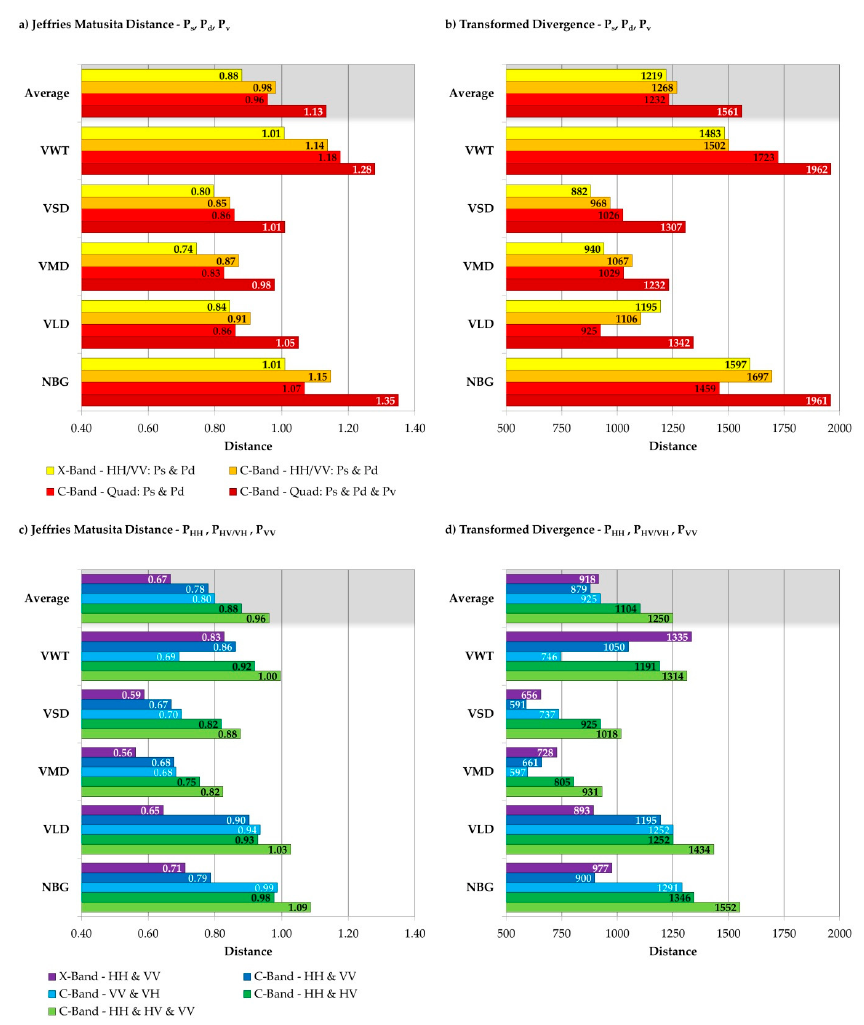
Figure 6. Average class separability measured as Jeffries Matusita Distance (JD) and Transformed Divergence (TD) for none-water land cover classes (NBG, VLD, VMD, VSD, VWT) and the average of